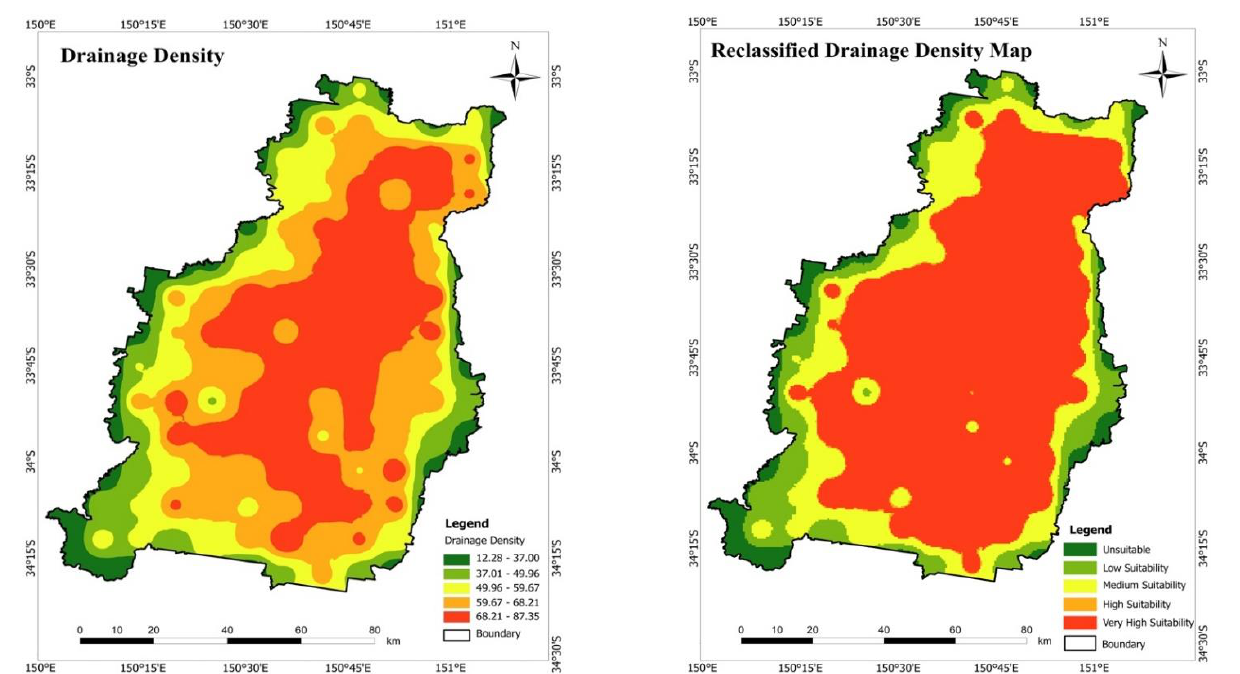
Figure 9. Study area’s stream order and reclassified map stream order ( left ); reclassified stream order ( right ).